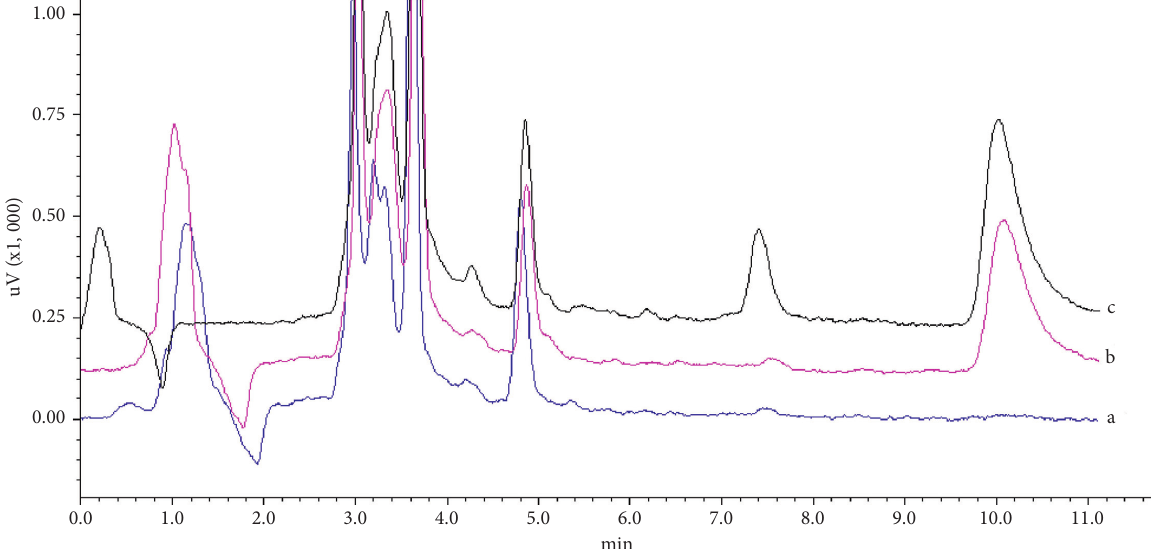
Figure 1: HPLC Chromatograms of BB in liver samples. Blank liver sample; (b) blank liver spiked with BB; and (c) liver sample after